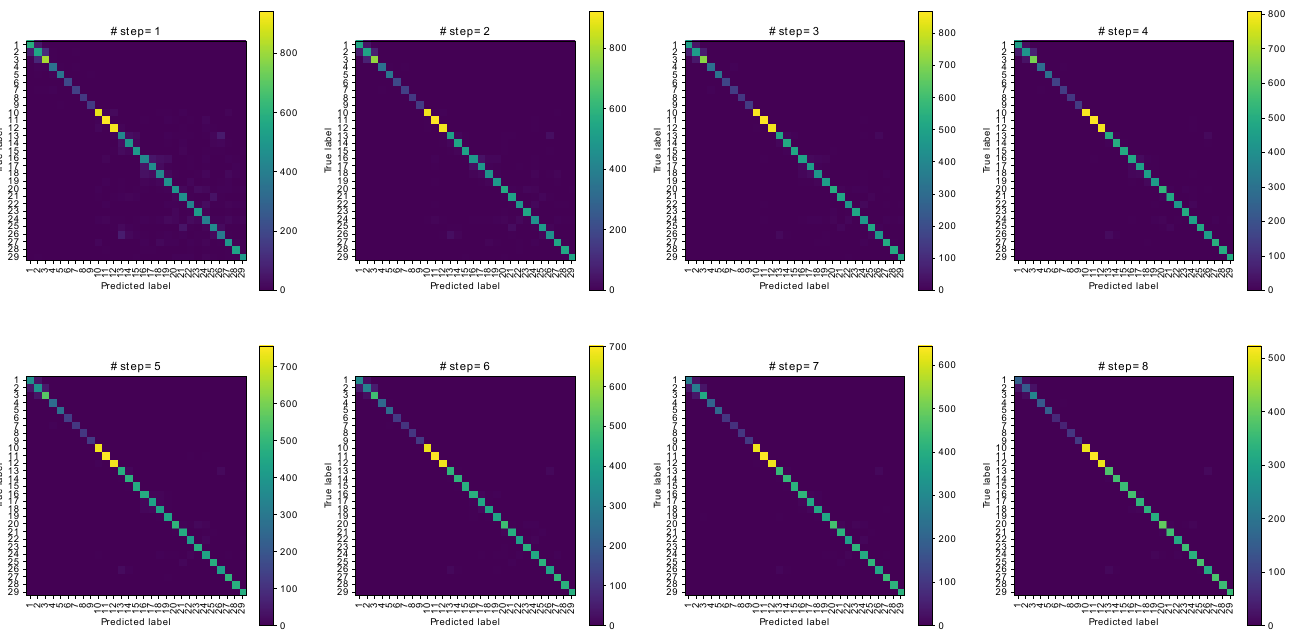
Figure 6. Confusion matrices of pedestrian identification with respect to the number of steps.